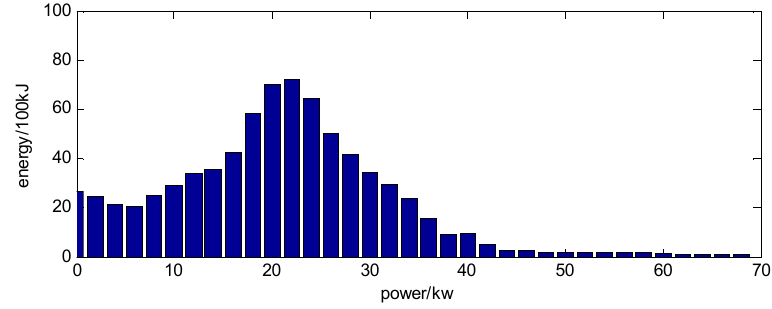
Figure 10. Output energy distribution of ESS in different discharge power .